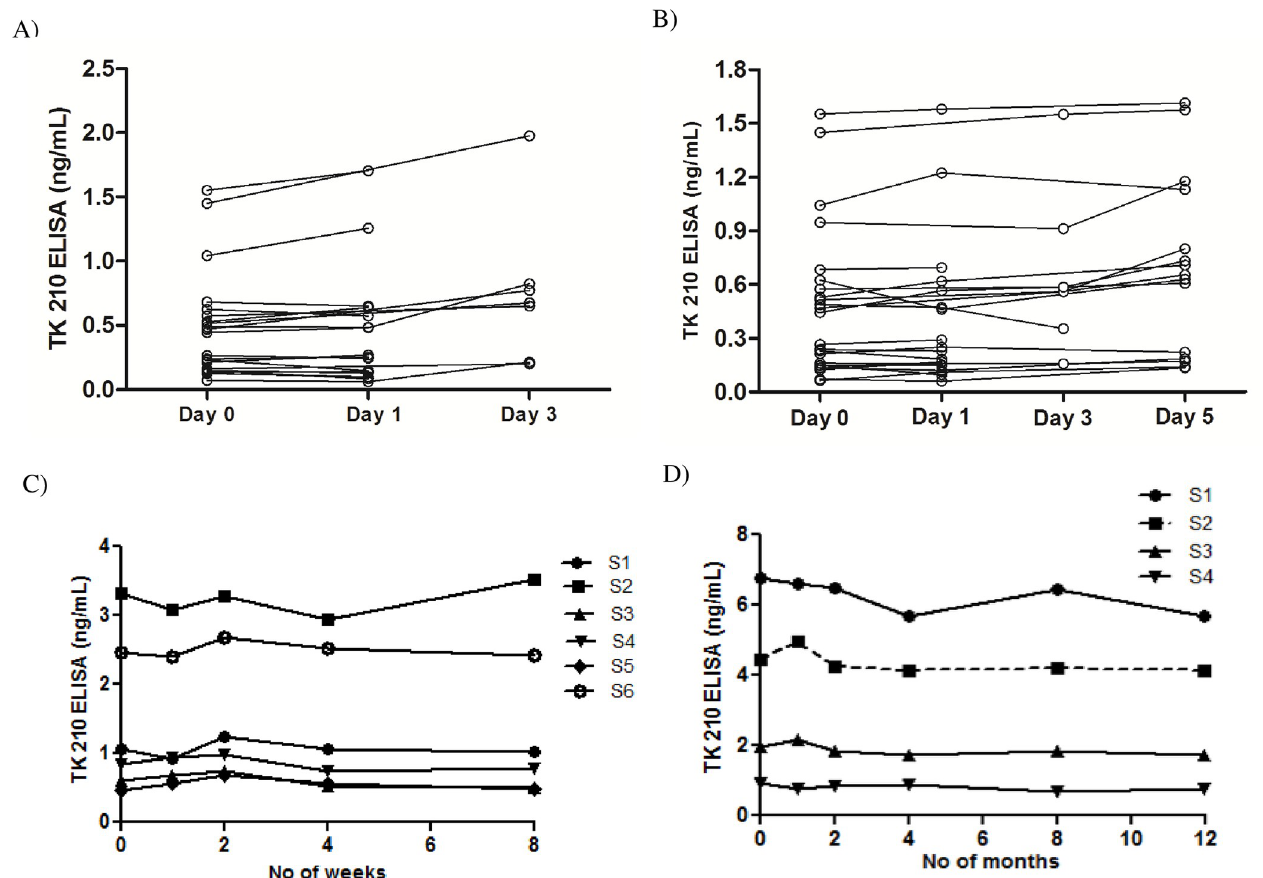
Fig 3. Stability of serum TK1 measured with AroCell TK 210 ELISA. (A) Serum TK1 protein stability at RT (22–25˚C). (B) Serum TK1 protein stability at 4˚C. (C) Serum TK1 protein stability of the clinical samples at -20˚C. (D) Sample TK1 protein stability at -80˚C.